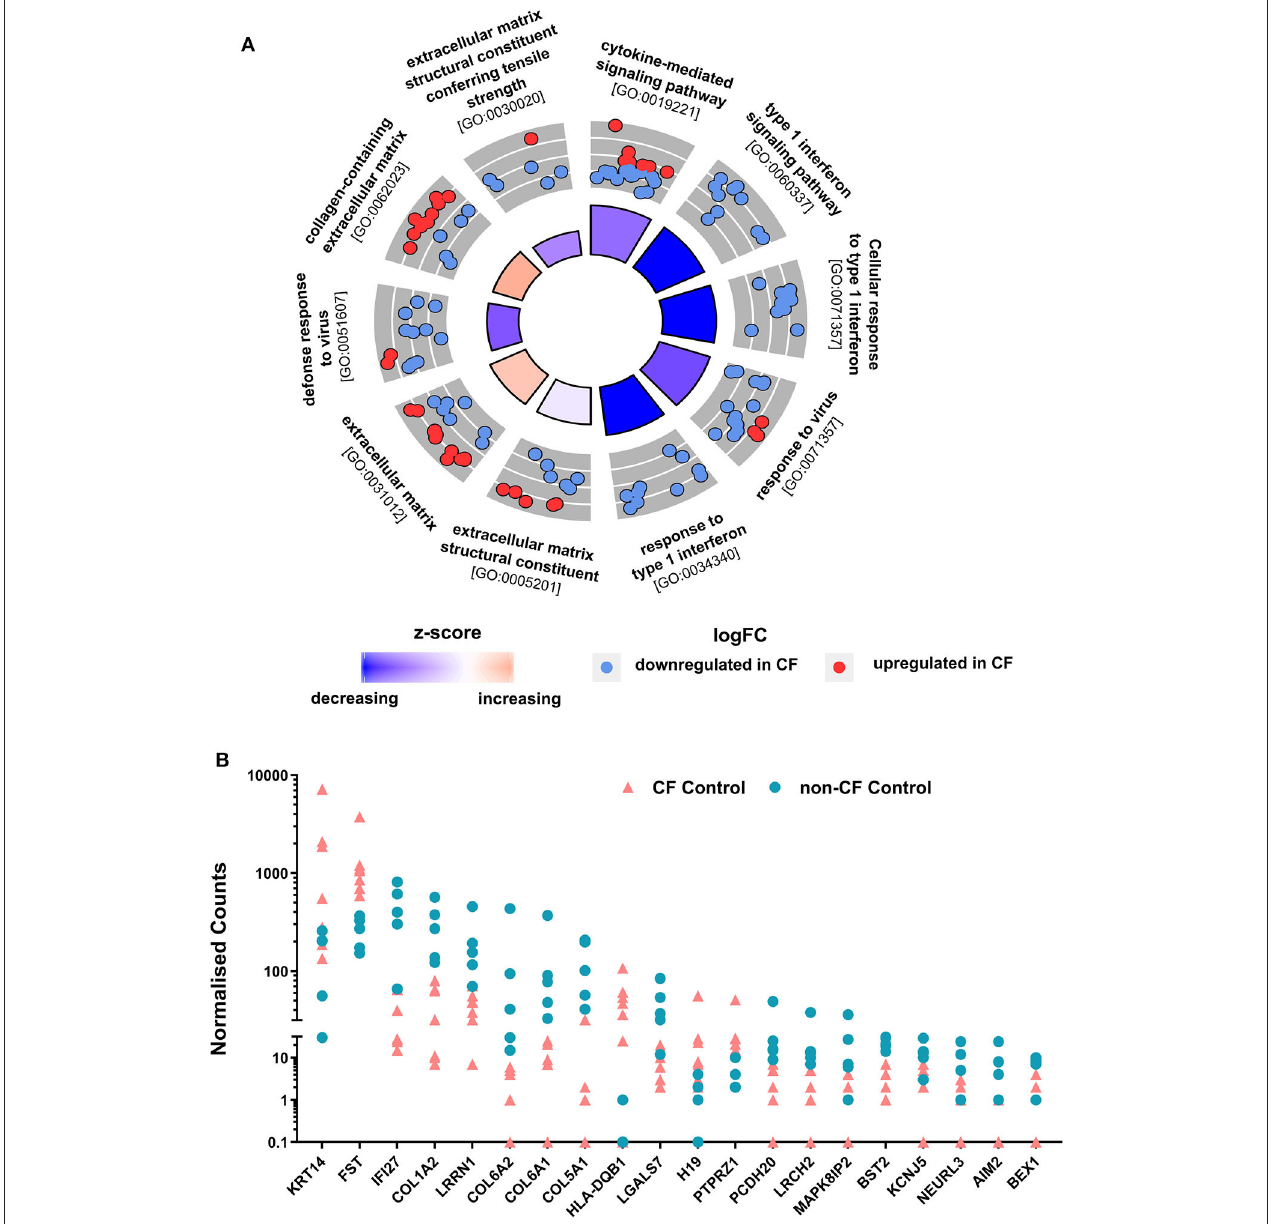
FIGURE 2 | Comparison of non-CF and CF non-infected baseline control. (A) Circular visualization of gene-annotation enrichment analysis of non-infected baseline samples. Statistically significant differentially expressed genes (DEGs) between non-infected CF and non-CF samples were annotated using gene ontology (GO). The circular plot combines gene expression and gene-annotation enrichment data. The outer circle shows a scatterplot for each enriched GO term of the Log2FC of the assigned genes. Red dots indicate upregulation, and blue dots indicate downregulation in CF non-infected control compared to non-CF. The inner ring is a bar plot where the height of the bar indicates the significance of GO terms (log10-adjusted p -value), and color corresponds to the z -score: blue, decreased; red, increased; and white, unchanged. (B) Normalized gene counts of the top 20 DEGs between CF and non-CF non-infected baseline samples with the highest fold change, data points represent individual samples for non-CF controls (turquoise; circle) and CF control (coral; triangle).